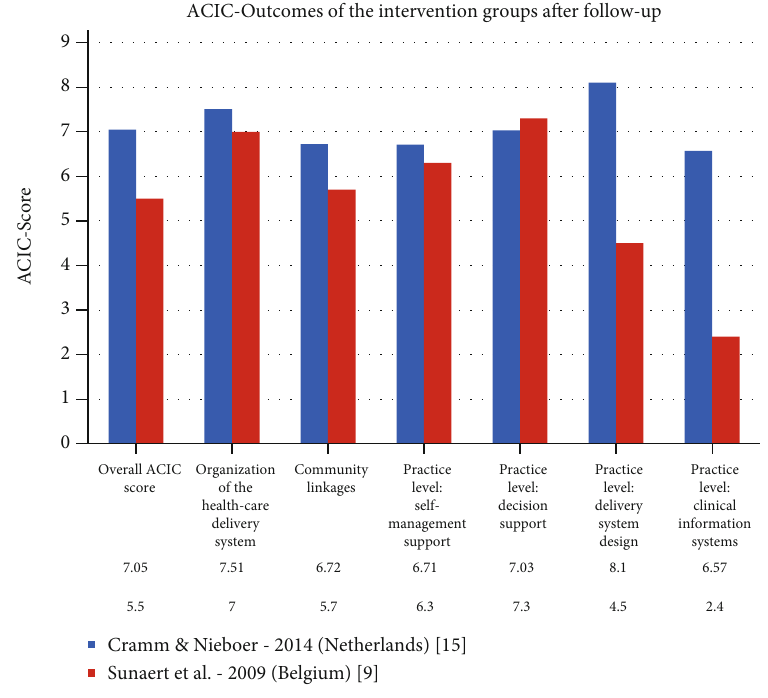
Figure 3: Comparison of the ACIC values.